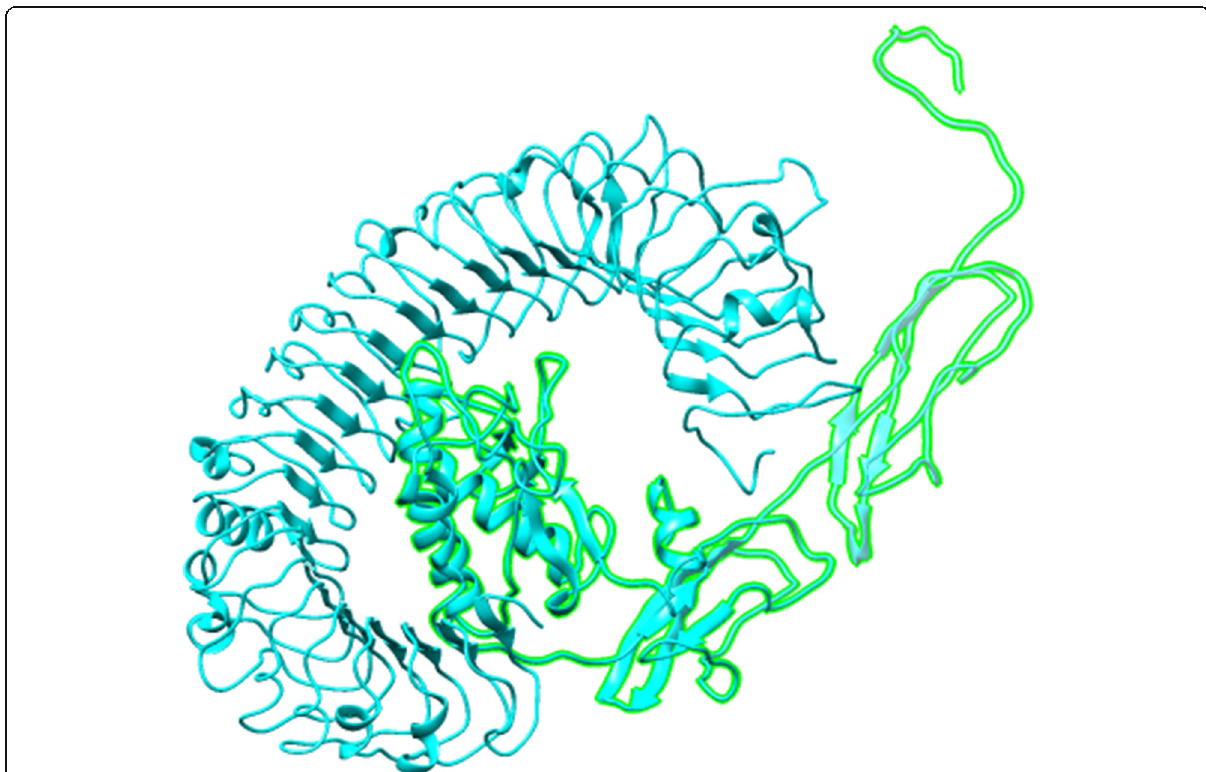
Fig. 7 Docked complex of TLR3 (receptor) and vaccine (ligand) generated by PatchDock. TLR3 is represented in Blue color and the Vaccine is represented in Green